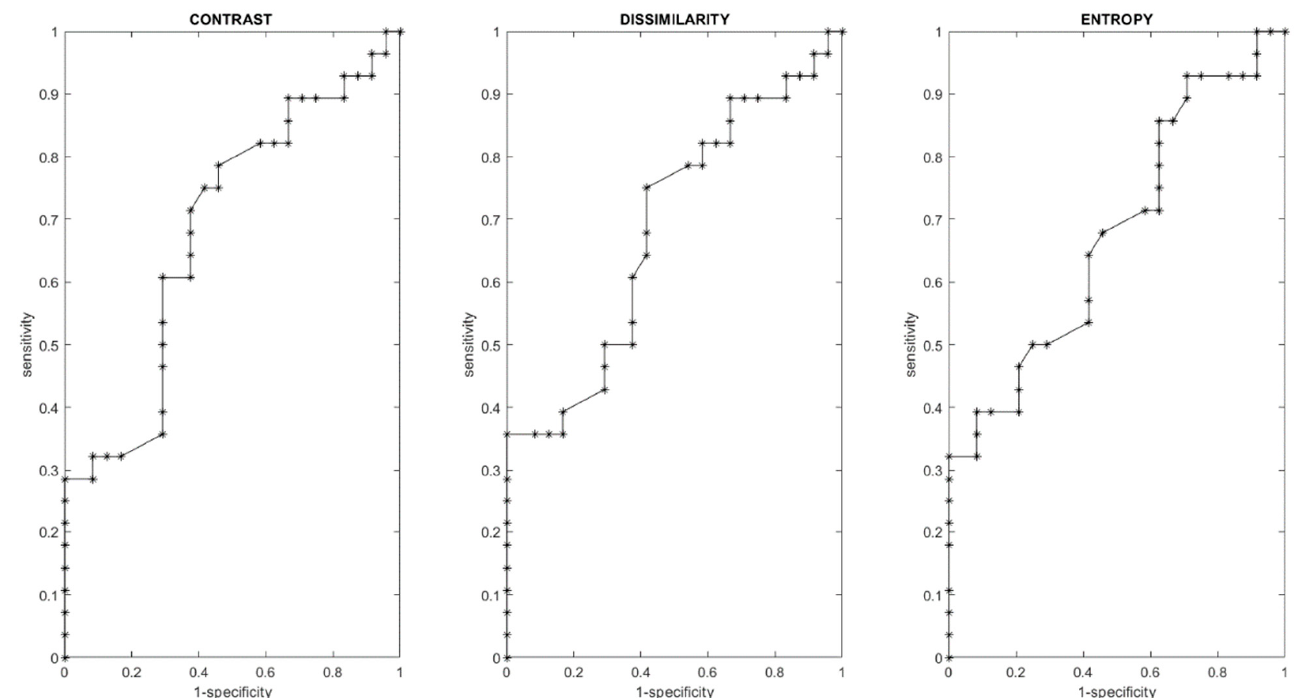
Figure 3. ROC curves for significant textual features to detect RAS